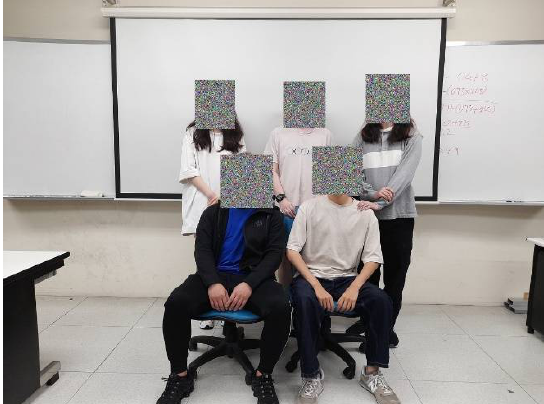
Figure 5. The encrypted result of multi-blocks.